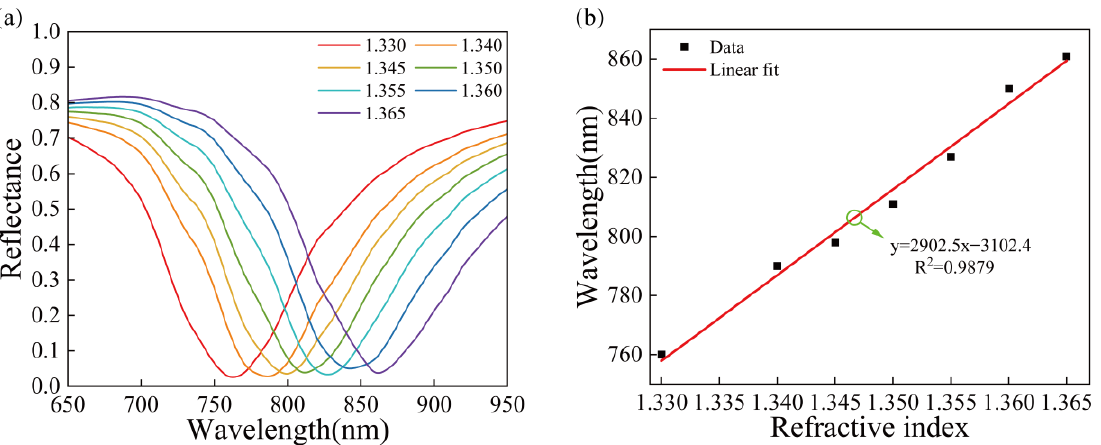
Figure 11. The reflectance curves of the Au/SiO 2 nanorod structure, ( a ) SPR curves for different refractive indices of the Au/SiO 2 nanorod structures, ( b ) relationship between the refractive index and the resonance wavelength and linear fitting.